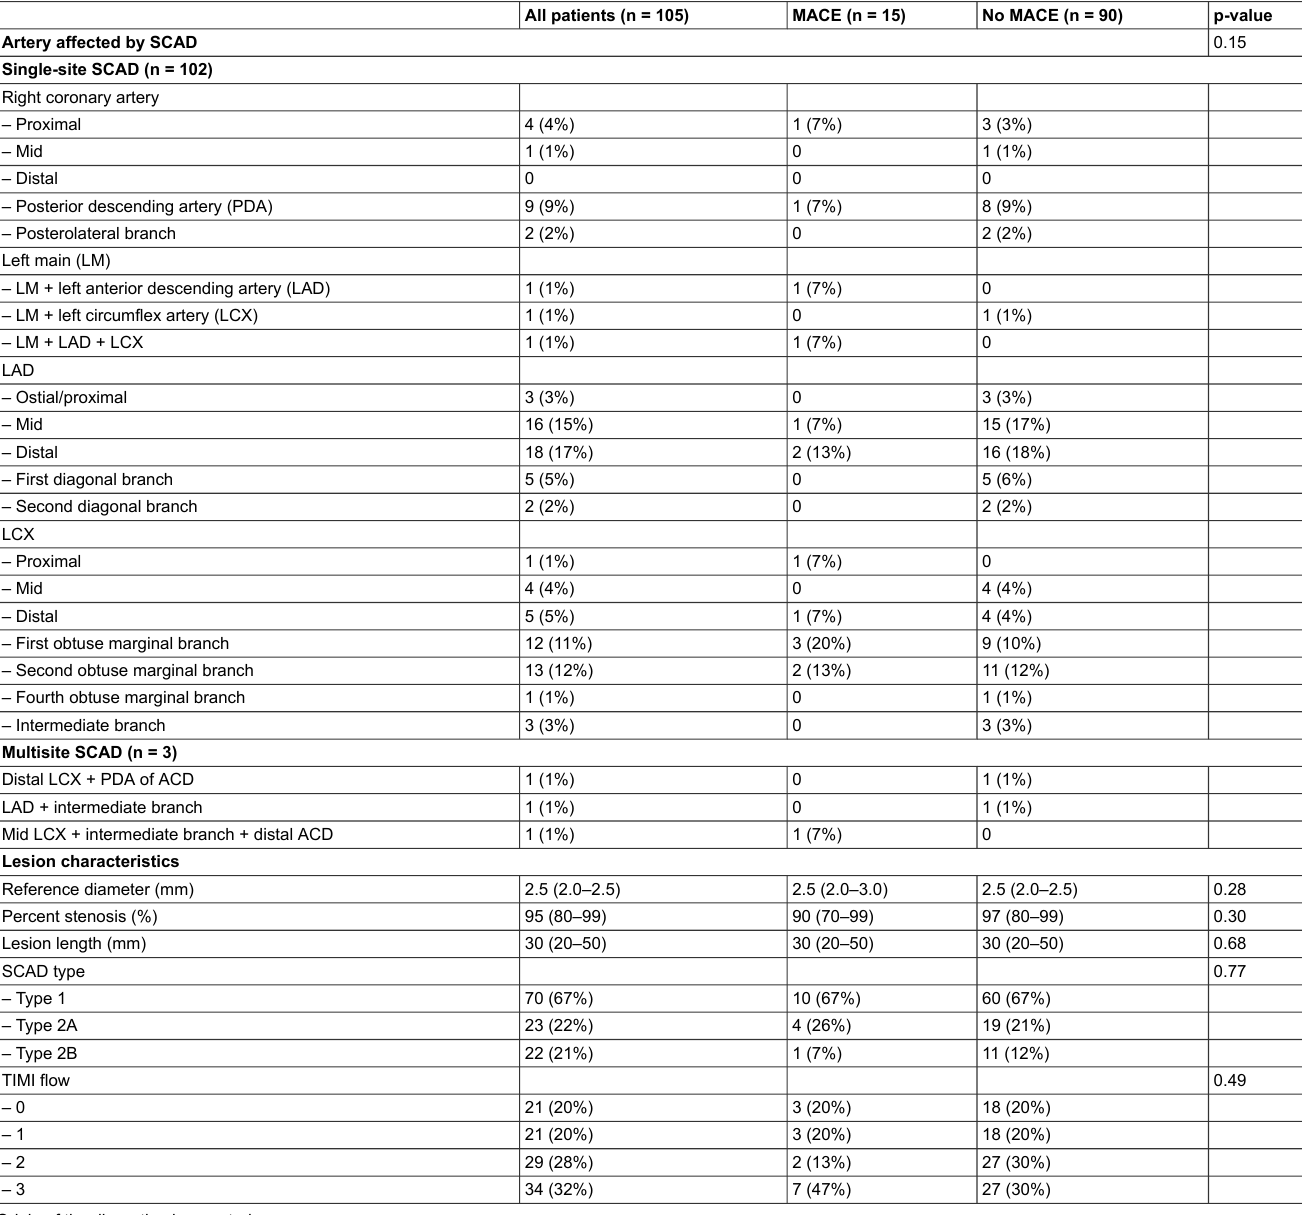
Table 2: Coronary anatomy of all patients with spontaneous coronary artery dissection (SCAD) and those with versus without major cardiac events (MACE).